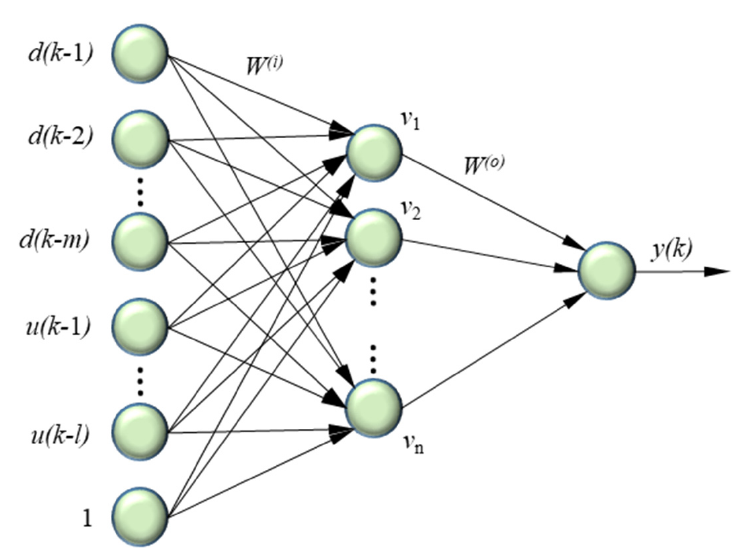
Figure 1. Network structure of series–parallel mode Jordan NARX network.